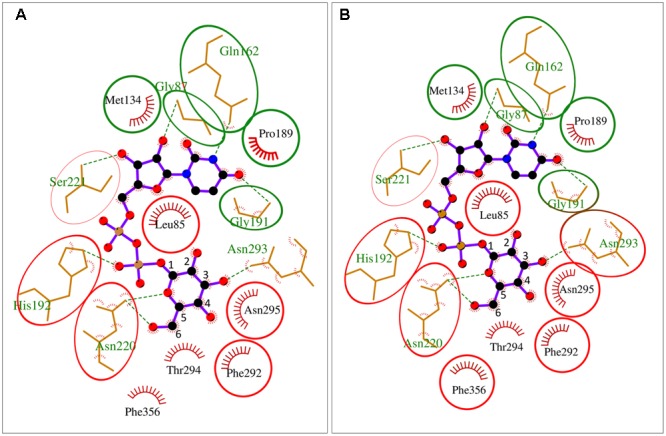
Schematic representation of UDP-Glc binding to AtUGPase1 vs. AtUSPase (A) and AtUGPase1 vs. AtUAGPase2 (B). Names of aa which interact or are in proximity of UDP-Glc are in black (hydrophobic interaction) or green font (hydrogen bond). Numbers for aa refer to UGPase aa sequence. Green circles mark the same type of aa residues in the comparable position for all three enzymes. Red circles mark aa which have an equivalent aa counterpart for a given UGPase/USPase and UGPase/UAGPase comparison. The uncircled aa are only found in AtUGPase. Active sites of the pyrophosphorylases were analyzed and presented using LigPlot+, based on the resolved crystal structure of AtUGPase1 (2ICY) and homology models of AtUSPase and AtUAGPase2, based on crystal structures of Leishmania USPase (PDB 3OH4) (Dickmanns et al., 2011) and human UAGPase (PDB 1JV1), (Peneff et al., 2001), respectively.